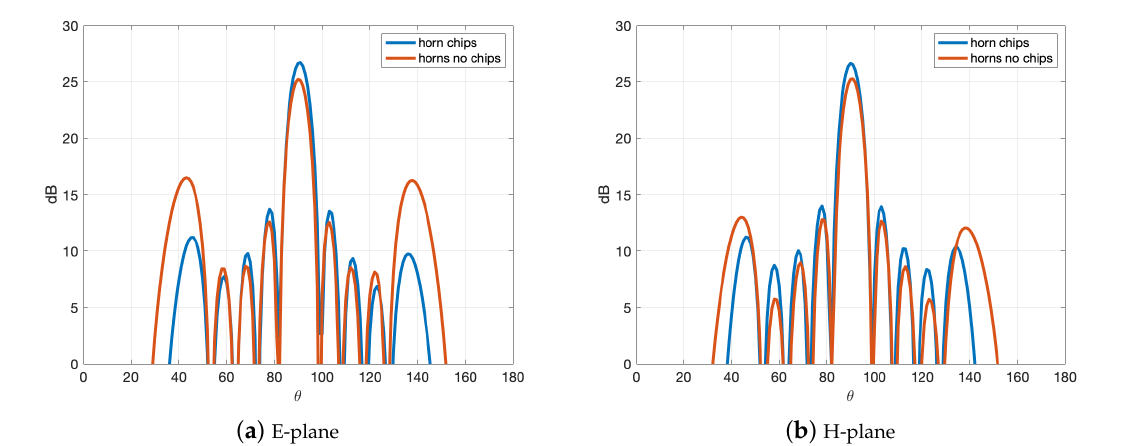
Figure 11. Simulated far-field directivity of the array of horns with and without chips, both fed by the 2D transverse waveguide slot